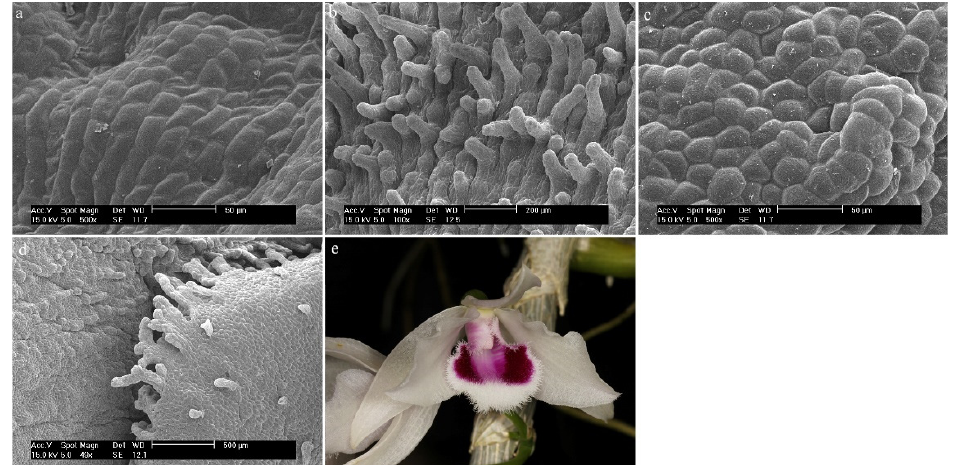
Figure 10. Dendrobium parishii H.Low: ( a ) the hypochile part of the labellum; ( b ) trichomes of the mesochile part of the labellum; ( c ) margin of the mesochile part of the labellum; ( d ) trichomes of the margin of the mesochile part of the labellum; ( e ) flower (photo by John Varigos). 6. Dendrobium regium Prain The hypochile is made up of regular epidermal cells. Rarely,